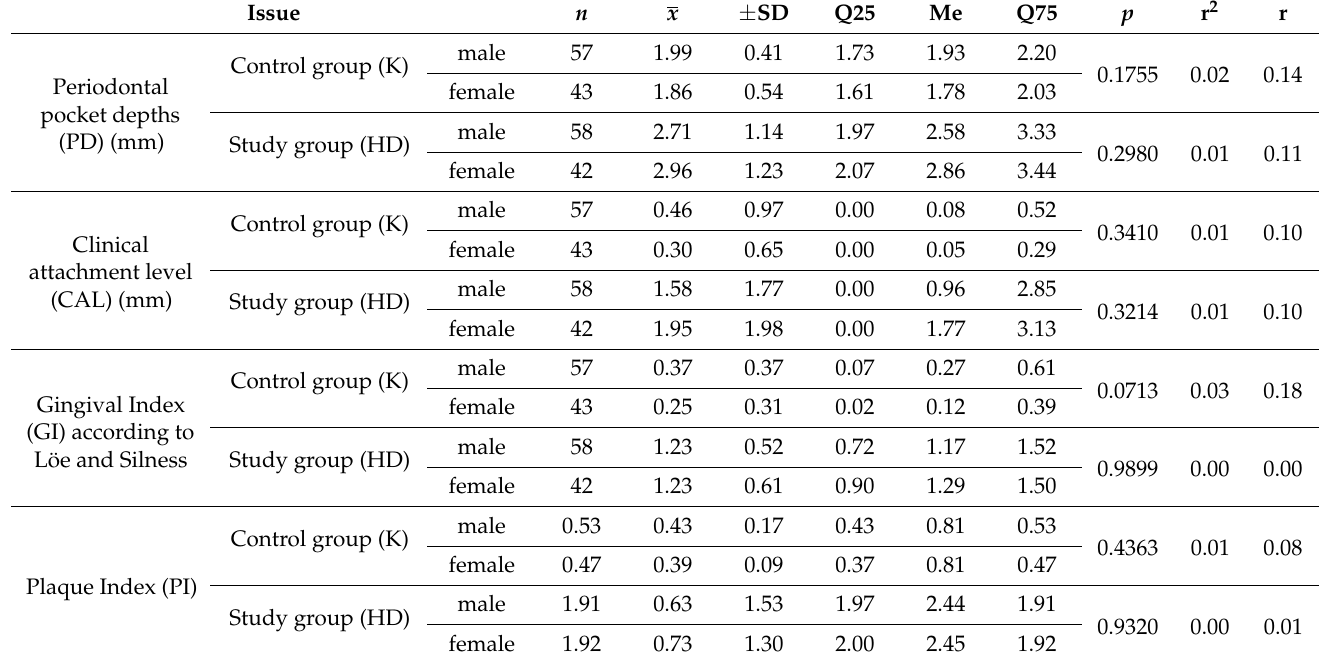
Table 10. Mean values of periodontal pocket depth (PD), clinical attachment level (CAL), Gingival Index (GI) according to Löe and Silness, and Plaque Index (PI) in the study groups concerning